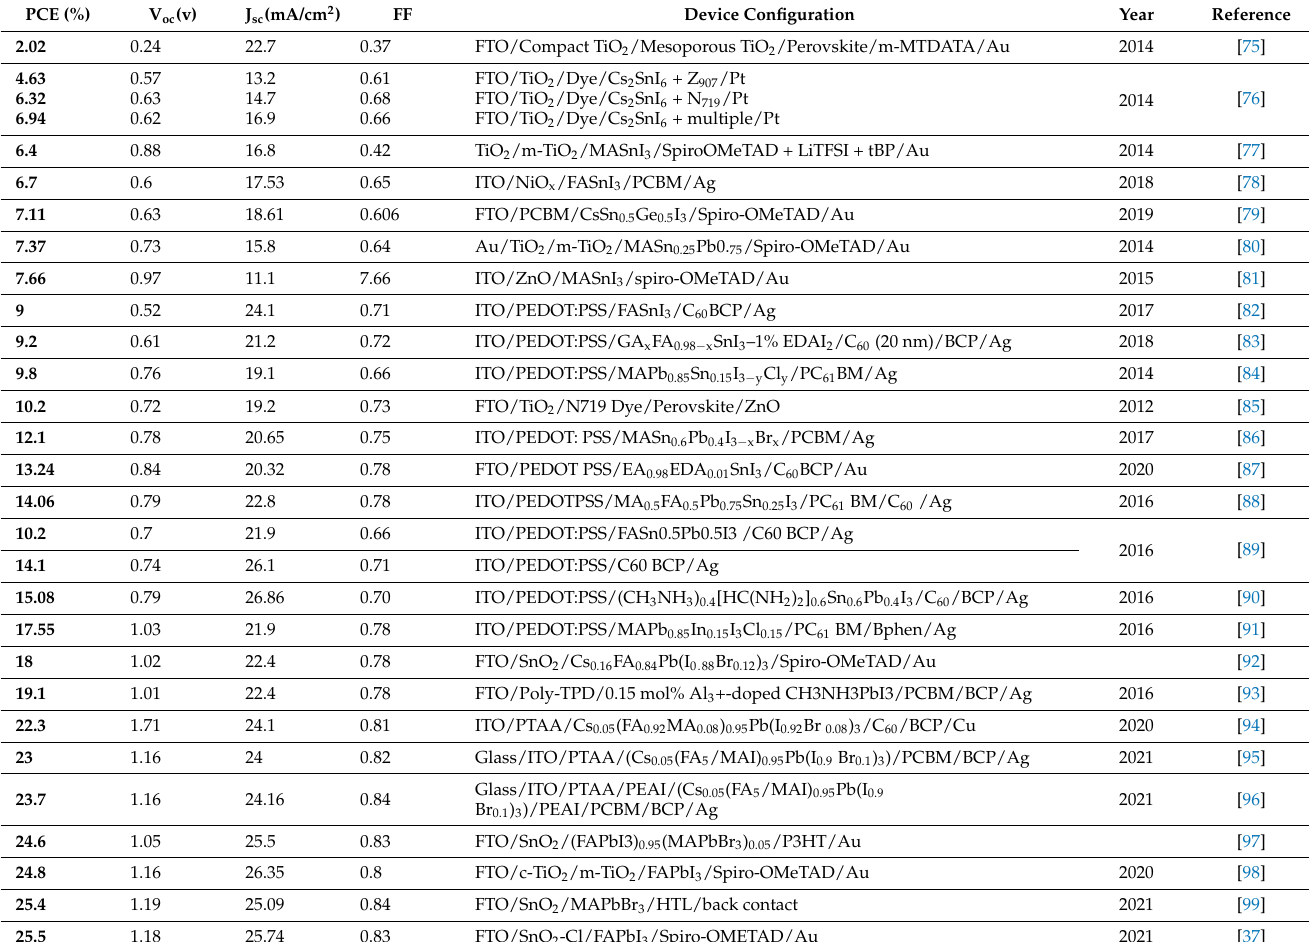
Table 2. Performance attained by various configurations of PSCs with progressive